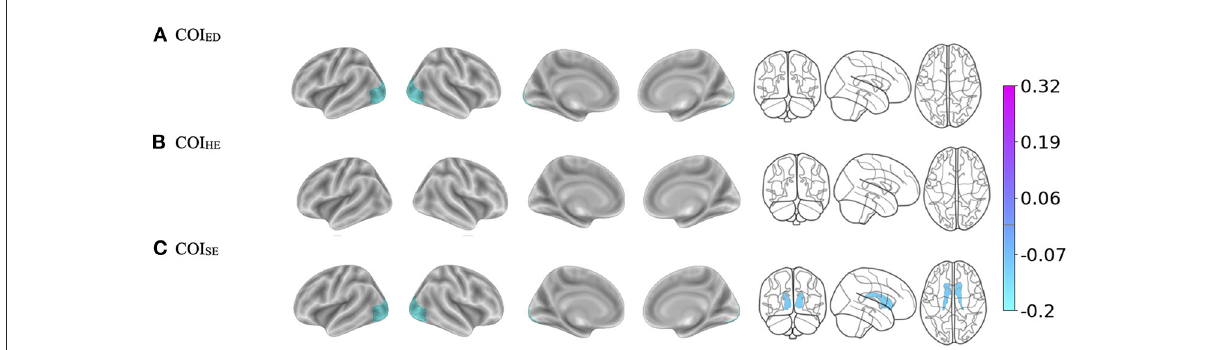
FIGURE2 (A–C) Visualization of the brain regions that showed significant three-way interactions with each Child Opportunity Index (COI) domain of interest by time (e.g., baseline, 2-year follow-up), controlling for the other two COI domains of no interest, income-to-needs, sex, puberty, race, and ethnicity. The color bar corresponds to the regression coefficients from the mixed models. There are no effects in (B) but the brain template is reported for ease of comparison. ED, education domain; HE, health/environmental domain; SE, social/economics domain.